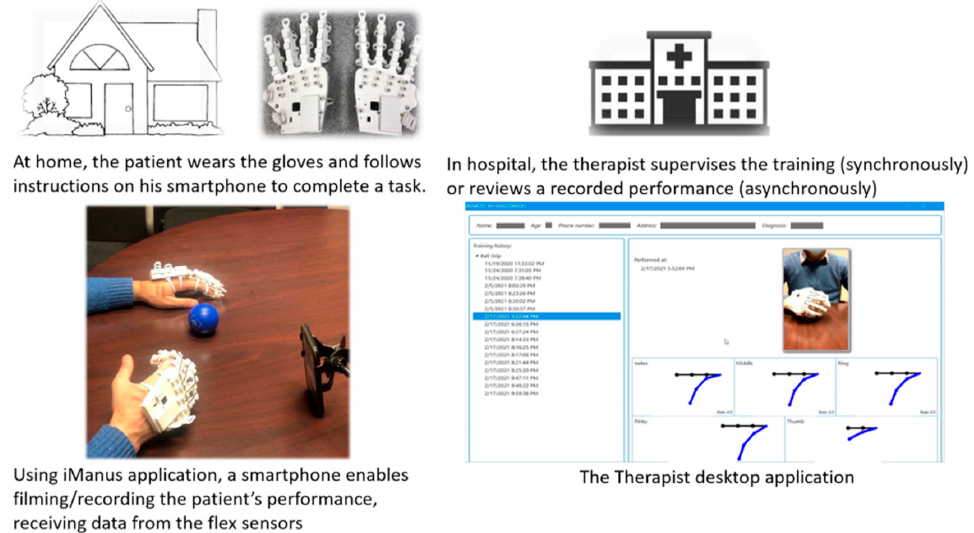
Figure 1. Overview of iManus platform.